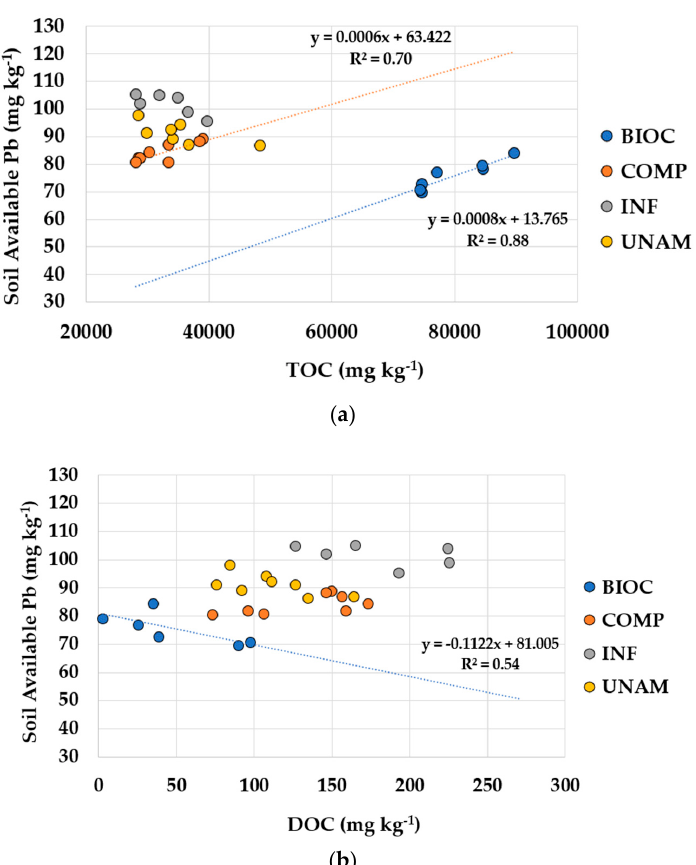
Figure 7. Relationship between soil available lead (Pb) and soil carbon parameters: ( a ) total organic carbon (TOC); ( b ) and dissolved organic carbon (DOC). Colors represent different treatments (biochar, BIOC; compost, COMP, inorganic fertilizer, INF, and unamended control, UNAM). When significant, a regression line accompanied by the slope equation and an R-sq value is shown for each individual amendment.